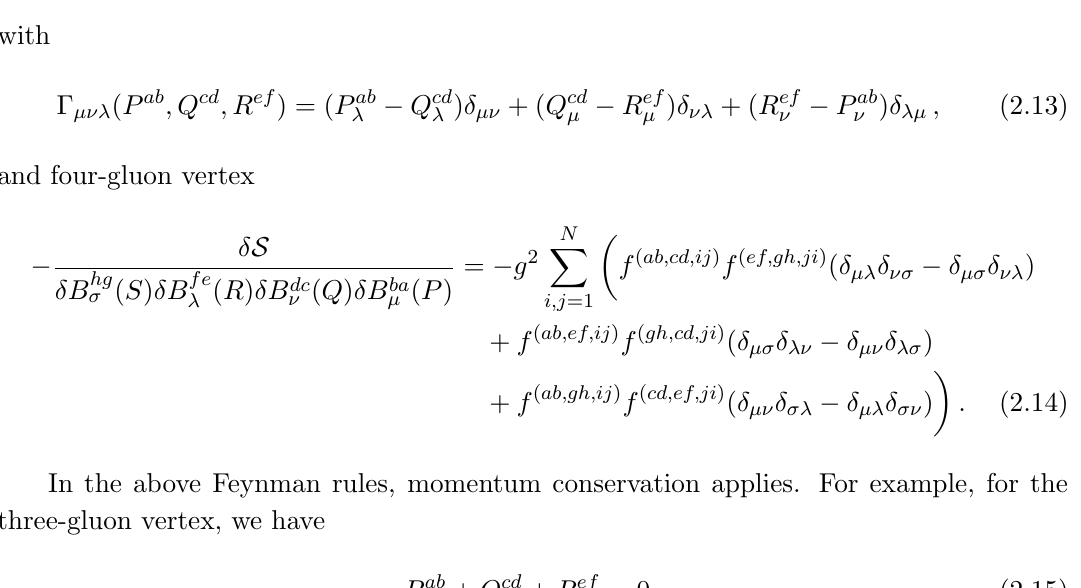
Figure 2 . Feynman diagrams for QCD free energy F up to two-loop